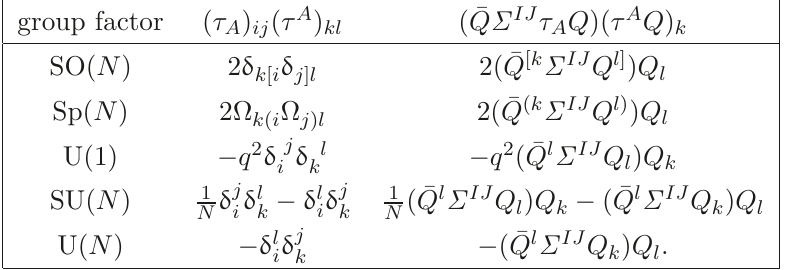
Table 2 . Generator identities and on-shell field strength terms for the classical gauge group factors. 2 N = 1 and N =